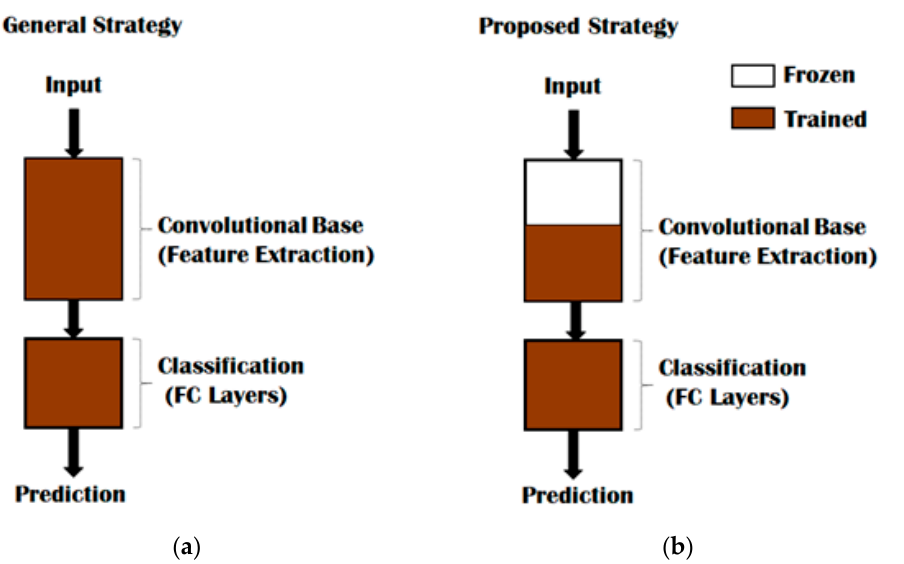
Figure 4. Training of the DNN Model: ( a ) indicates a general strategy where both convolutional base and classification layers are trained; ( b ) represents our proposed strategy where we froze part of the layers in the convolutional base.